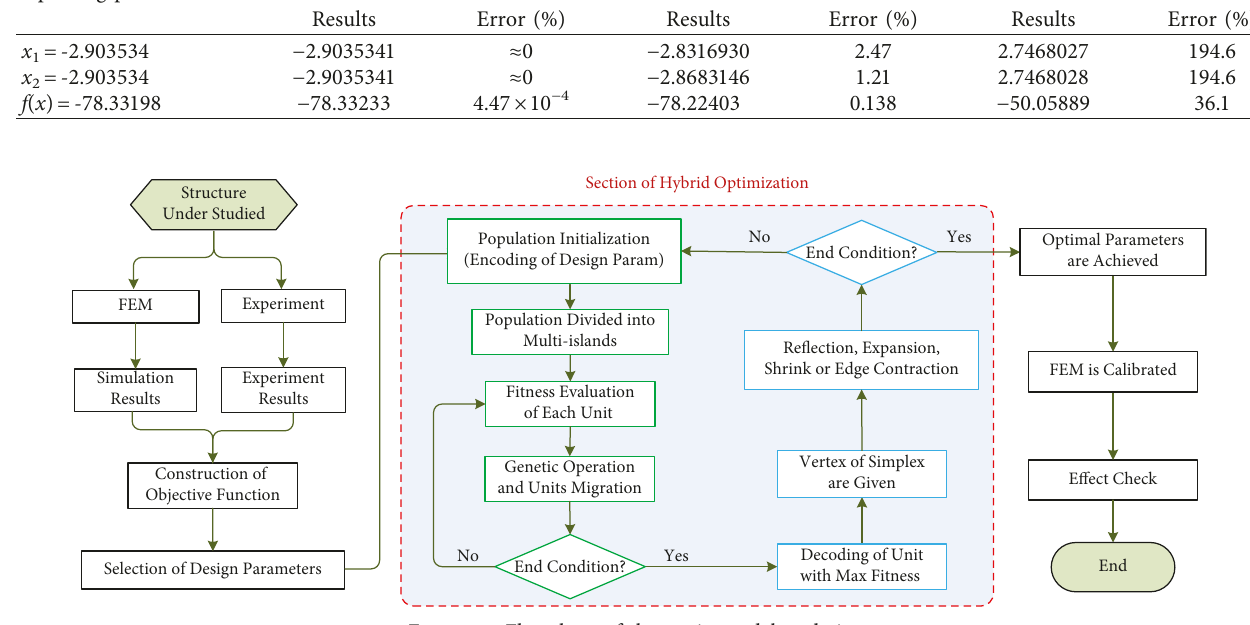
Figure 5: Flowchart of the static model updating.